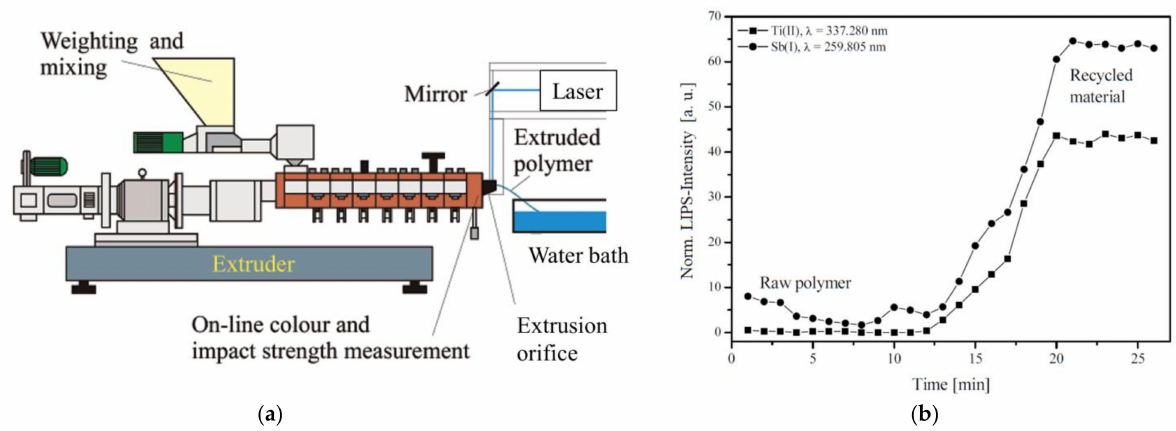
Figure 22. LIBS in-line measurement of polymers in a recycling plant. ( a ) Schematic of the LIBS sensor installed at a polymer extruder. ( b ) Detection of different types of polymer material at the extruder by means of LIBS intensities measured for Ti and Sb. Adapted from